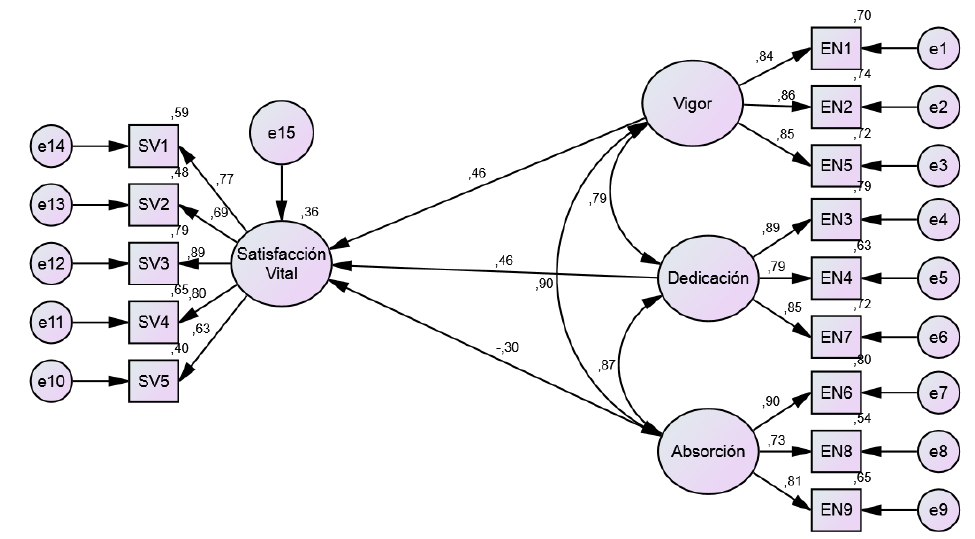
Figure 1. Structural Model of Life Satisfaction and Academic Engagement.